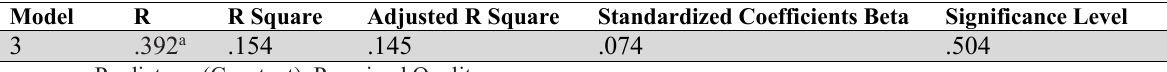
Model Summary for the third hypothesis